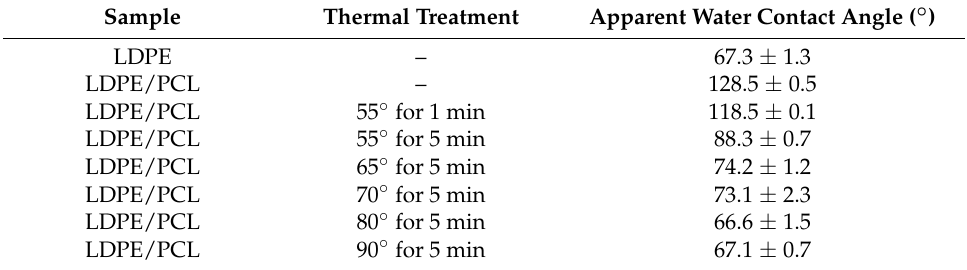
Table 1. Apparent water contact angles obtained for the low-density polyethylene (LDPE) film and the electrospun poly( ε -caprolactone) (PCL) fibers deposited for 2 h onto the LDPE films that underwent different thermal post-treatments. The values are reported as means ± standard